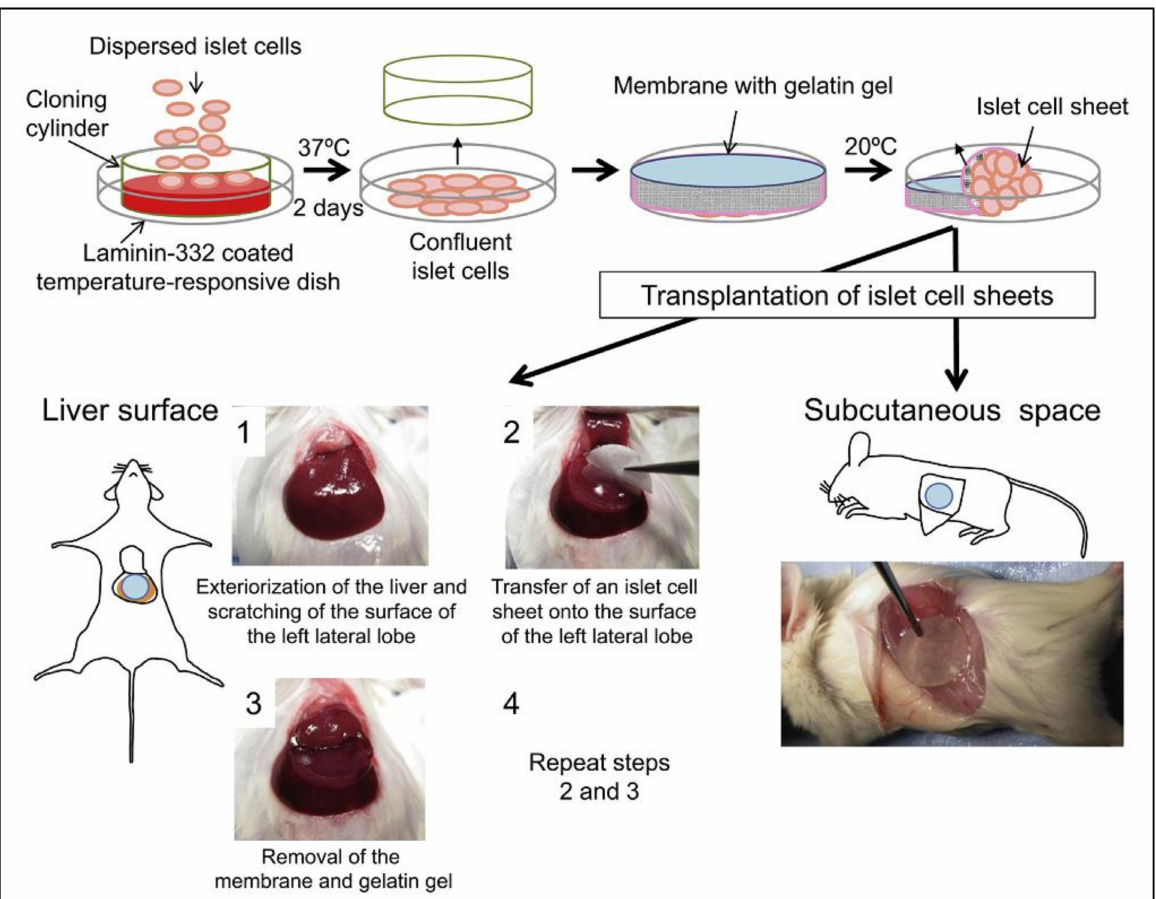
Figure 6. Schematic of the recovery and transplantation of rat islet cell sheets from a temperature-responsive dish (TRD) using a gelatin/membrane. Dispersed rat islet cells were seeded into a cloning cylinder, placed on a laminin-332-coated TRD and cultured for 2 days at 37 ◦ C. The islet cell sheets were recovered from TRDs using gelatin/membranes and transplanted onto the liver surface or the subcutaneous spaces of STZ-induced diabetic SCID mice. Adapted with permission [132]; published by The Japanese Society for Regenerative Medicine,